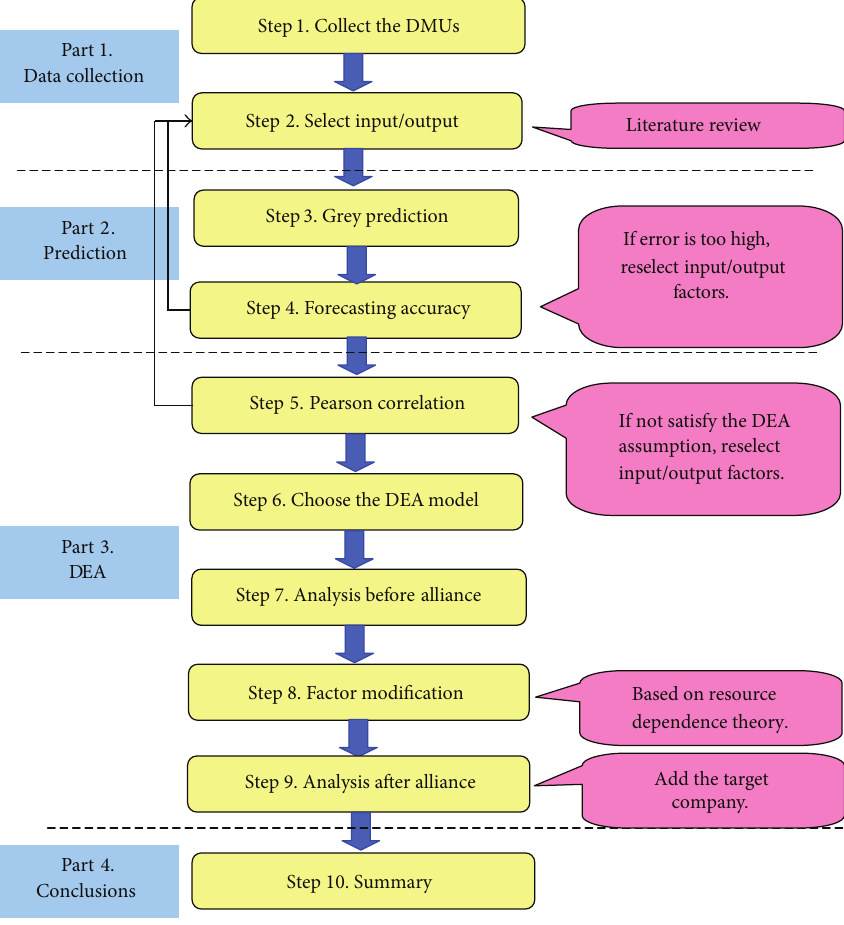
Figure 2: Research